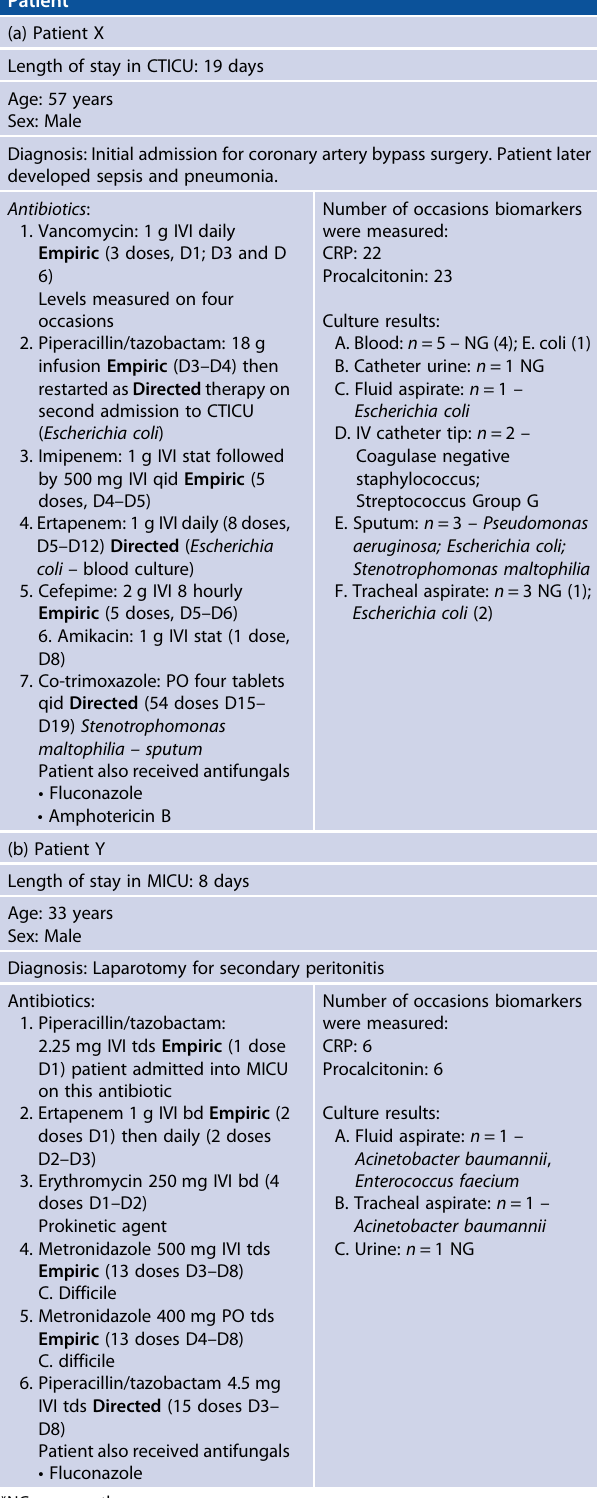
Table 2: Brief case review of patients who received (a) seven and (b) six antibiotics while admitted to ICU